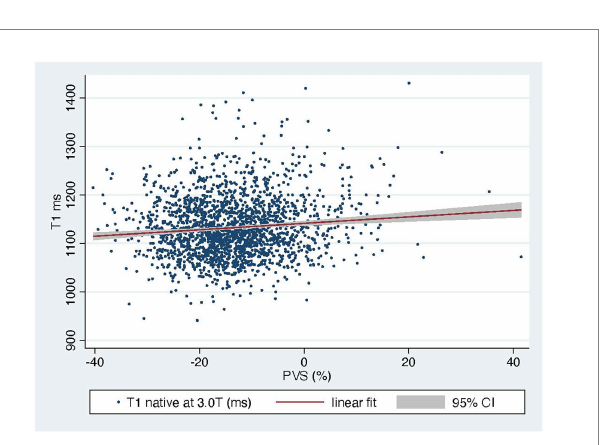
FIGURE 2 Linear prediction of native T1 by PVS shows a weak but significant